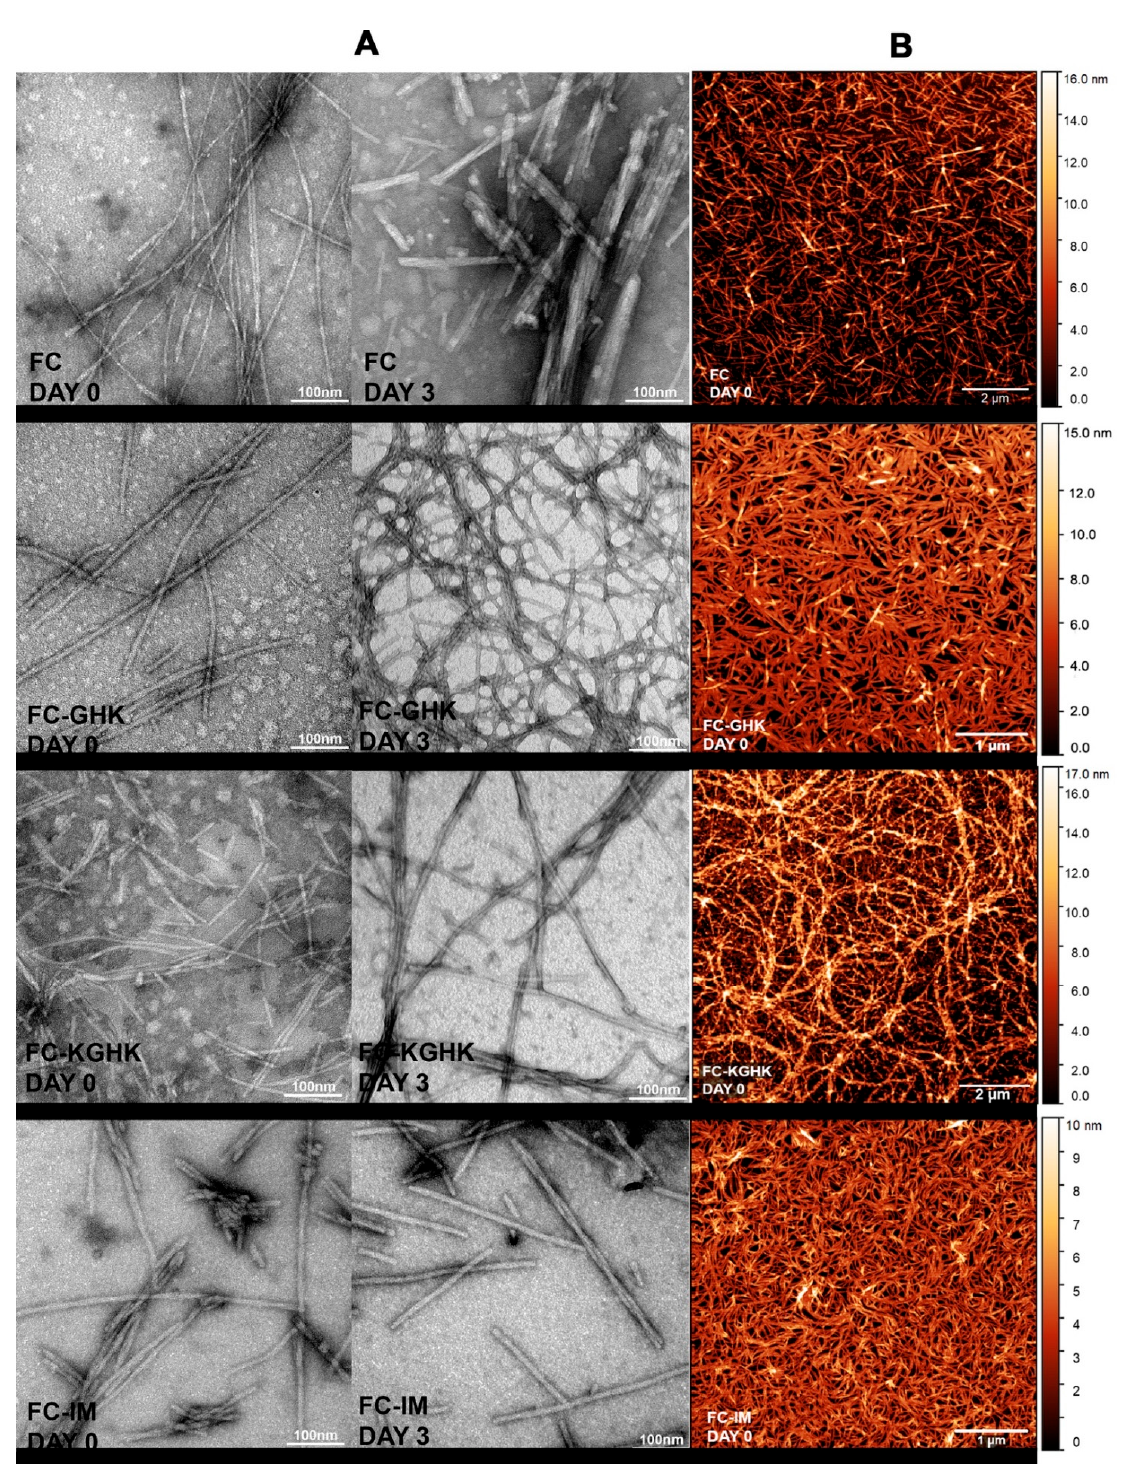
Figure 3. ( A ) Transmission electron micrographs (TEM) for peptides FC, FC-GHK, FC-KGHK and FC-IM taken before and on the 3 rd day of incubation in PBS buffer; ( B ) Atomic force microscopy (AFM) images of fibrils taken briefly after dissolution in PBS buffer.